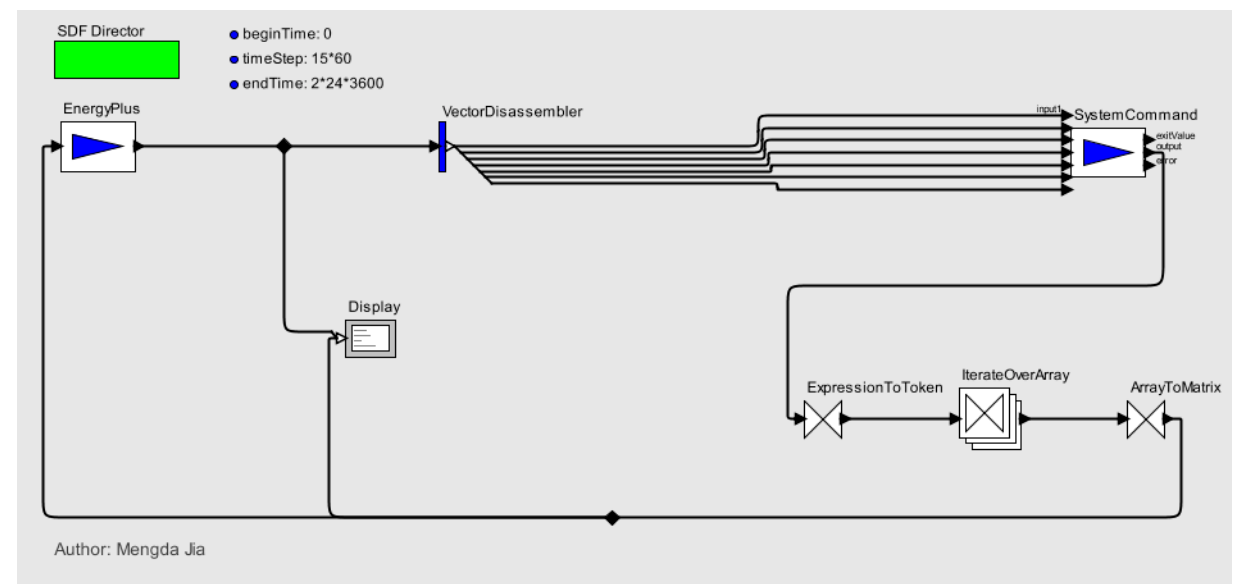
Figure A2. Logical connection for the two simulators in BCVTB graphical interface for co-simulation execution.